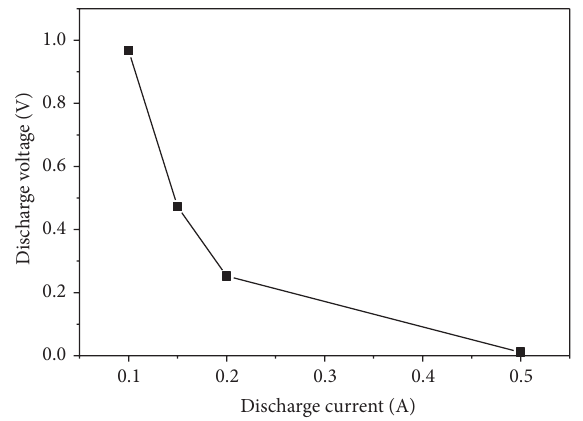
Figure 5: Polarization curves of the battery with quaternized polysulfone membranes at different discharge